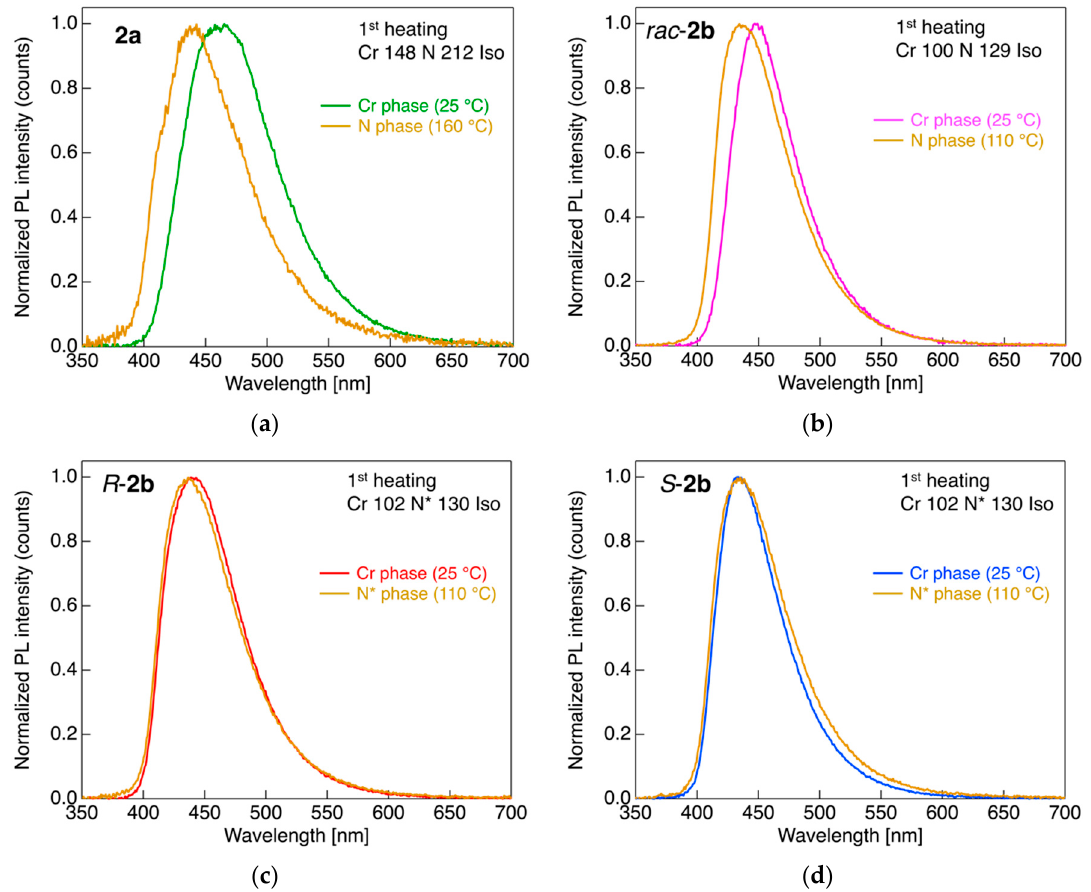
Figure 7. PL spectra of ( a ) 2a with Cr-phase (green) and N-phase (yellow) molecular aggregates, ( b ) rac - 2b with Cr-phase (pink) and N-phase (yellow) molecular aggregates, ( c ) R - 2b with Cr-phase (red) and N*-phase (yellow) molecular aggregates, and ( d ) S - 2b with Cr-phase (blue) and N*-phase (yellow) molecular aggregates. Abbreviations: Cr: crystal, N: nematic, N*: chiral nematic, Iso: isotropic phases.